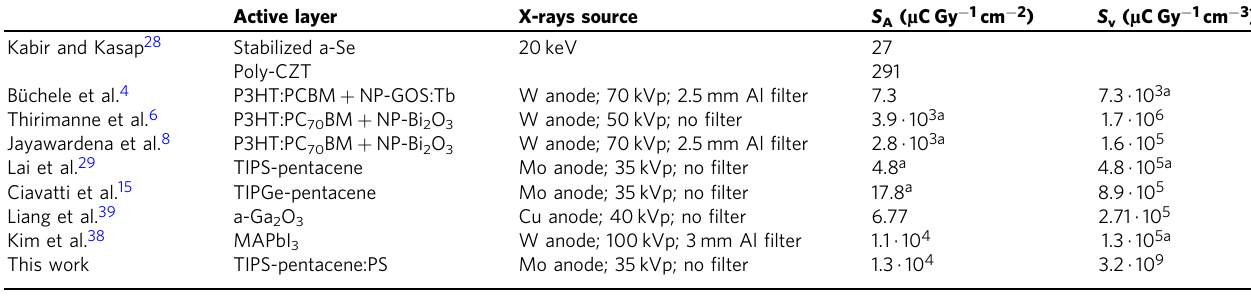
a Values extracted by the device information reported in the referenced